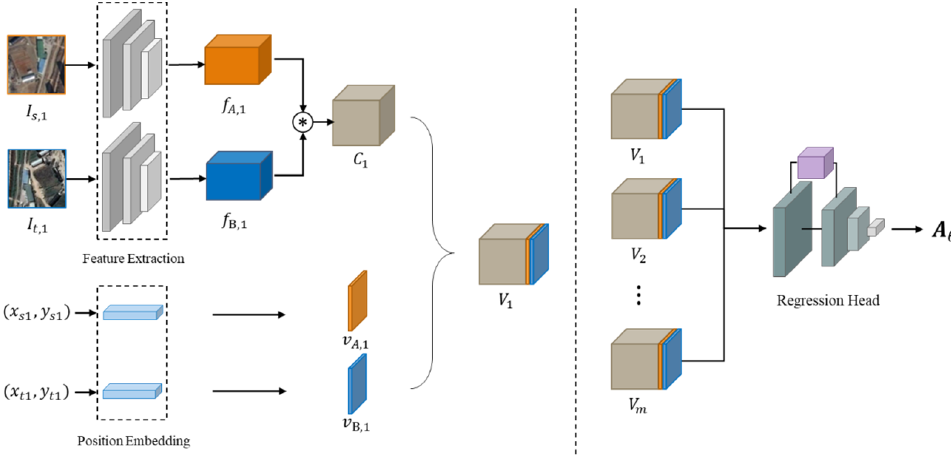
Figure 6. Network architecture of ETP. I s and I t represent the input source sub-images and the target sub-images, respectively. C 1 represents the correlation map from I s ,1 and I t ,1 . ( x s , y s ) and ( x t , y t ) represent the coordinates of the images to which they belong. v vectors after encoding. v A , v B , and C are concatenated into feature block V . A θ denotes the final transformation matrix.